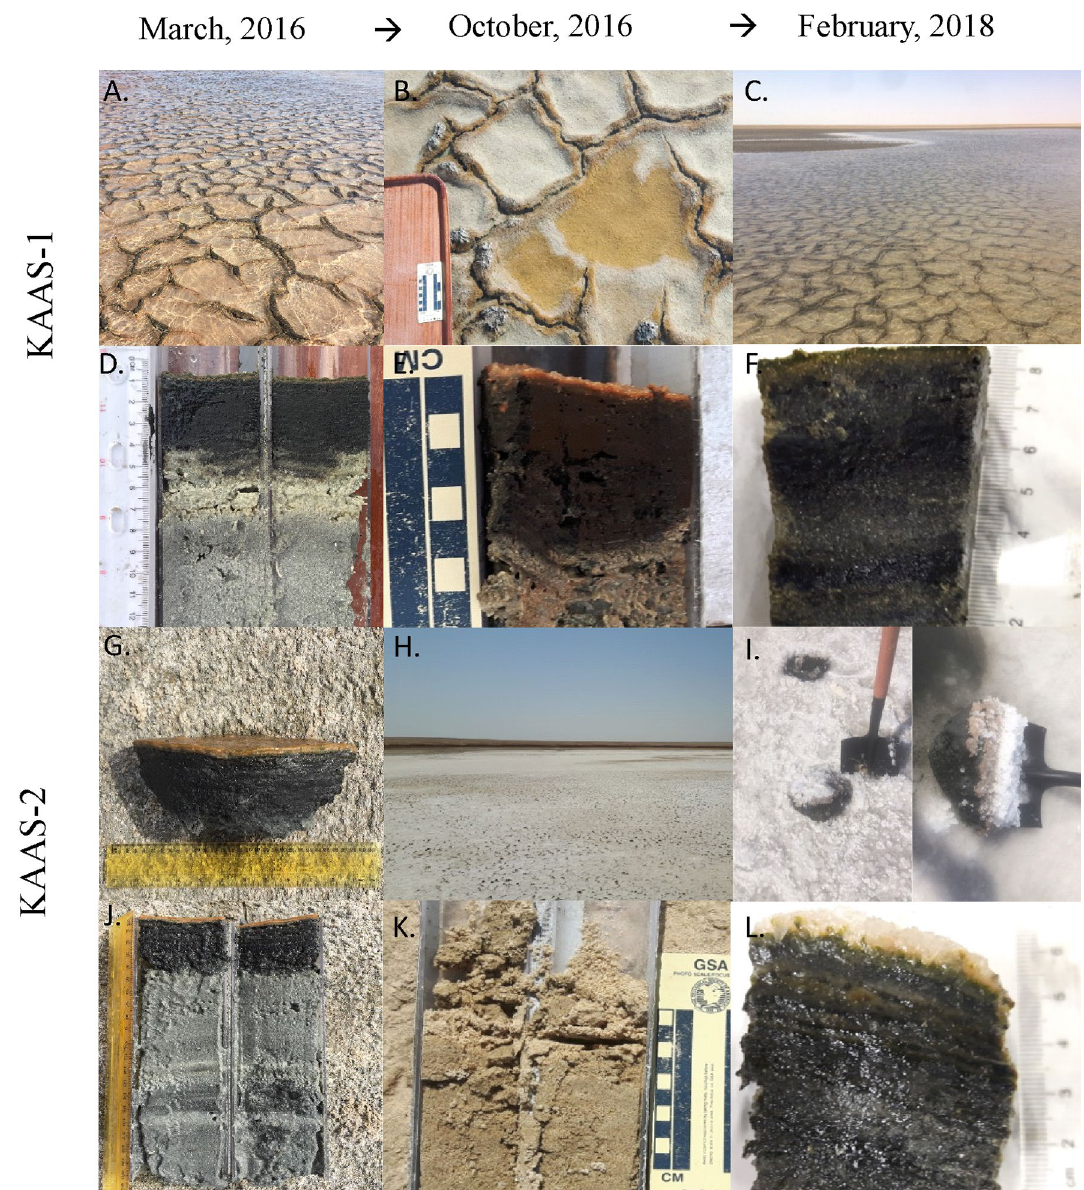
Figure 1. (A ) Surface of KAAS-1 during March 2016. ( B ) Surface of KAAS-1October 2016. ( C ) Surface of KAAS-1 February 2018. ( D ) Vertical profile of KAAS-1 during March 2016 consisting of the thin upper green layer with intermixed pink and red layers (≈0.5 cm), the thicker middle black layer (≈4.5 cm), and the bottom-most grey layers composing the rest of the profile. ( E ) Vertical profile of KAAS-1 October 2016 with the uppermost orange layer and intermixed pink and orange layer (≈0.5 cm), the middle black layer (≈5 cm), and upper (6 cm), middle (8 cm) and lower grey (> 8 cm) layers. (F ) Vertical profile of KAAS-1 in February 2018 with green, red and orange layers intermixed (≈0.5 cm), middle black layer (5 cm) and bottom grey layer (> 5 cm) ( G ) Surface of KAAS-2 during March 2016 with extracted portion of mat (middle). ( H ) Dried out surface of KAAS-2 October 2016. ( I ) Salt encrusted surface of KAAS-2 February 2018 and extracted mat portion (left). ( J ) Vertical profile of KAAS-2 during March 2016 showing the orange and red layers (≈0.2 cm), middle black layer (4 cm), and bottom grey layer (> 4 cm). ( K ) Vertical profile of KAAS-2 in October 2016 showing a surficial crust and desiccated core. ( L ) Vertical profile of February 2018 showing a clear-gel underneath the removed salt-encrustation, an intermixed orange, green and red layer (≈1 cm), followed by a middle black layer (3 cm) and the intermixed transition between the black and bottom grey layers (> 3